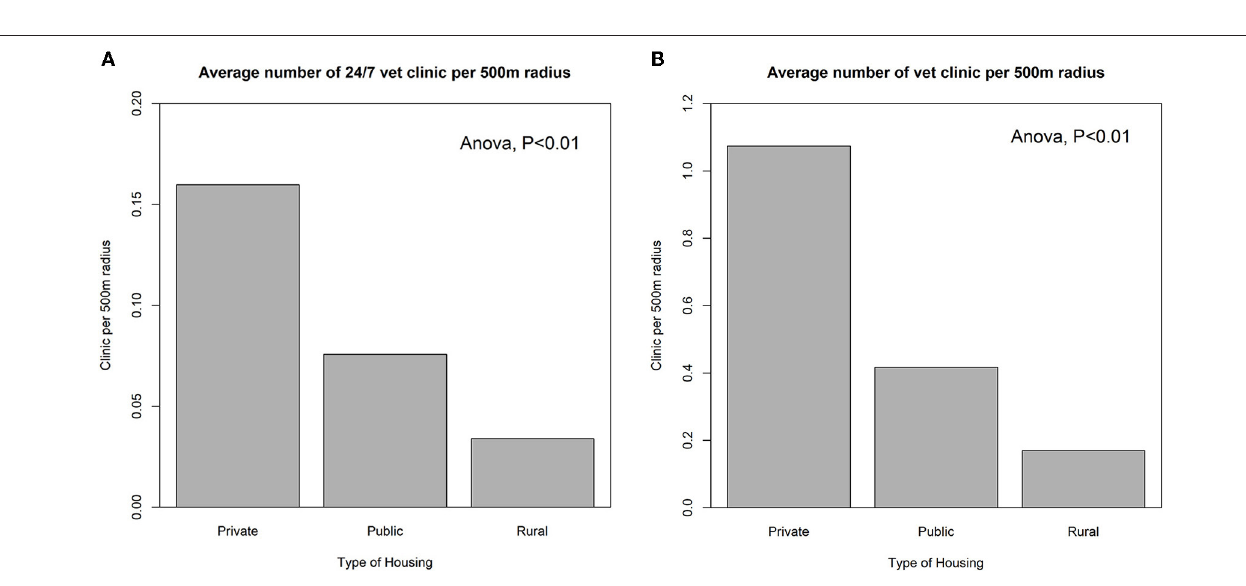
FIGURE 7 | The average number of (A) general and (B) 24/7 vet clinics by housing type per 500m radius per 10m x 10m grid in the residential